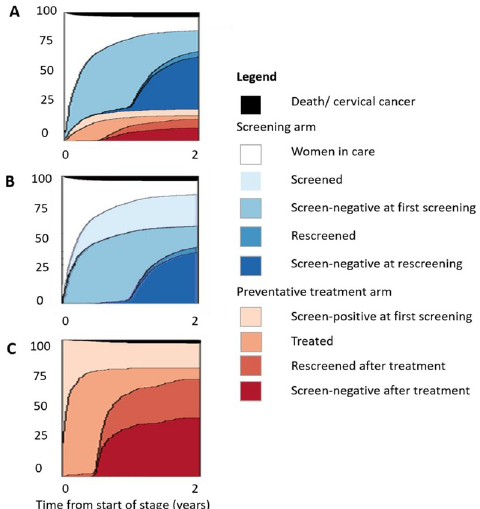
Fig 4. Analysis of cumulative incidence–percentage of women living with HIV (WLHIV) transitioning through the Cervical Cancer Screening Cascade by year. The two-year cumulative incidence of WLHIV transitioning to each stage of the Cervical Cancer Screening Cascade—Panel A: Cervical Cancer Screening Cascade, time zero: date of first ART clinic visit; Panel B: screening arm, time zero: date of first ART clinic visit; Panel C: preventative treatment arm, time zero: date of initial